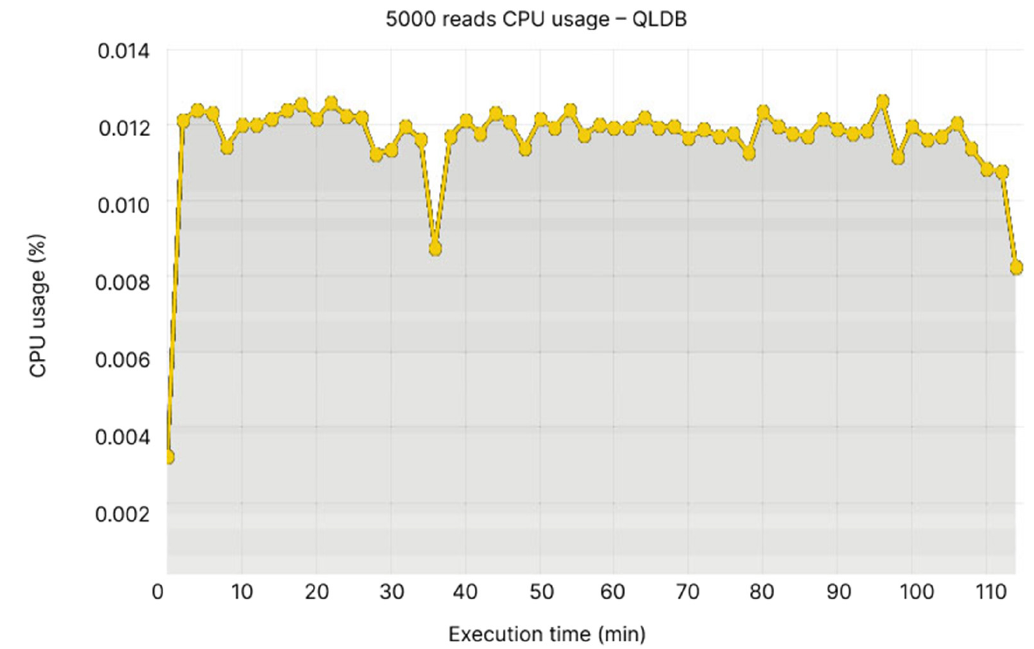
Figure 23. 5000 reads CPU usage—QLDB.